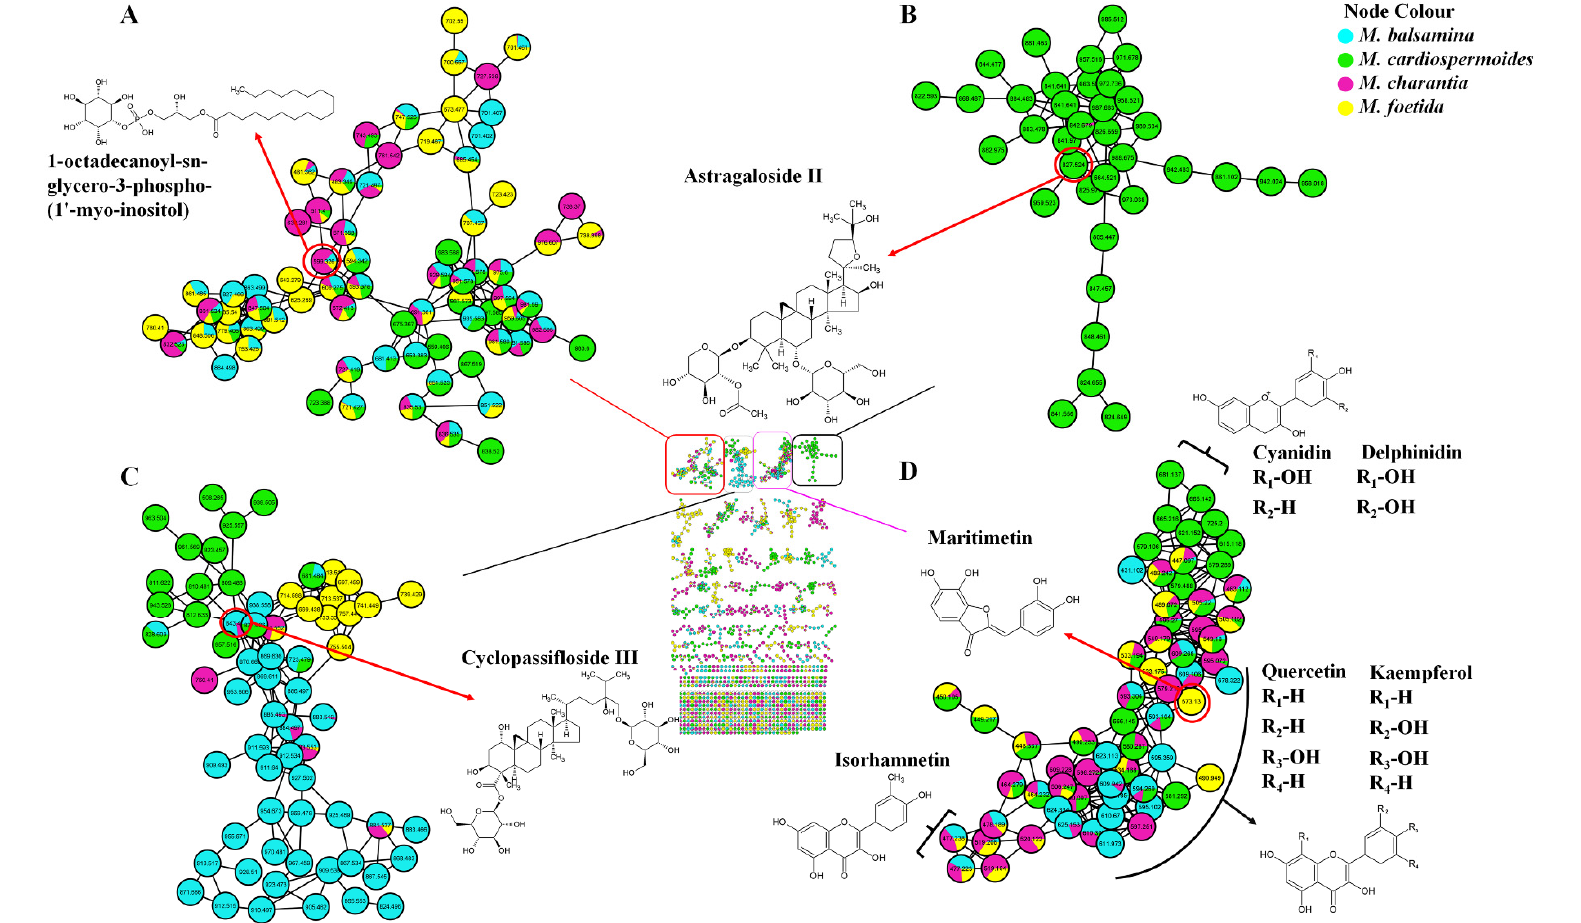
Figure 1. Molecular network of Momordica species extracts analysed by liquid chromatography–tandem mass spectrometry using electrospray ionisation in negative mode (centre), with four major metabolite classes identified highlighted here glycerophospholipids ( A ), triterpenoids ( B ), terpene glycosides ( C ) and flavonoids ( D ). Highlighted are also the aglycones/backbones from which the flavonoids identified are derived. Node colours represent the studied Momordica species and the respective MS 2 spectral counts indicating presence and absence of metabolites.